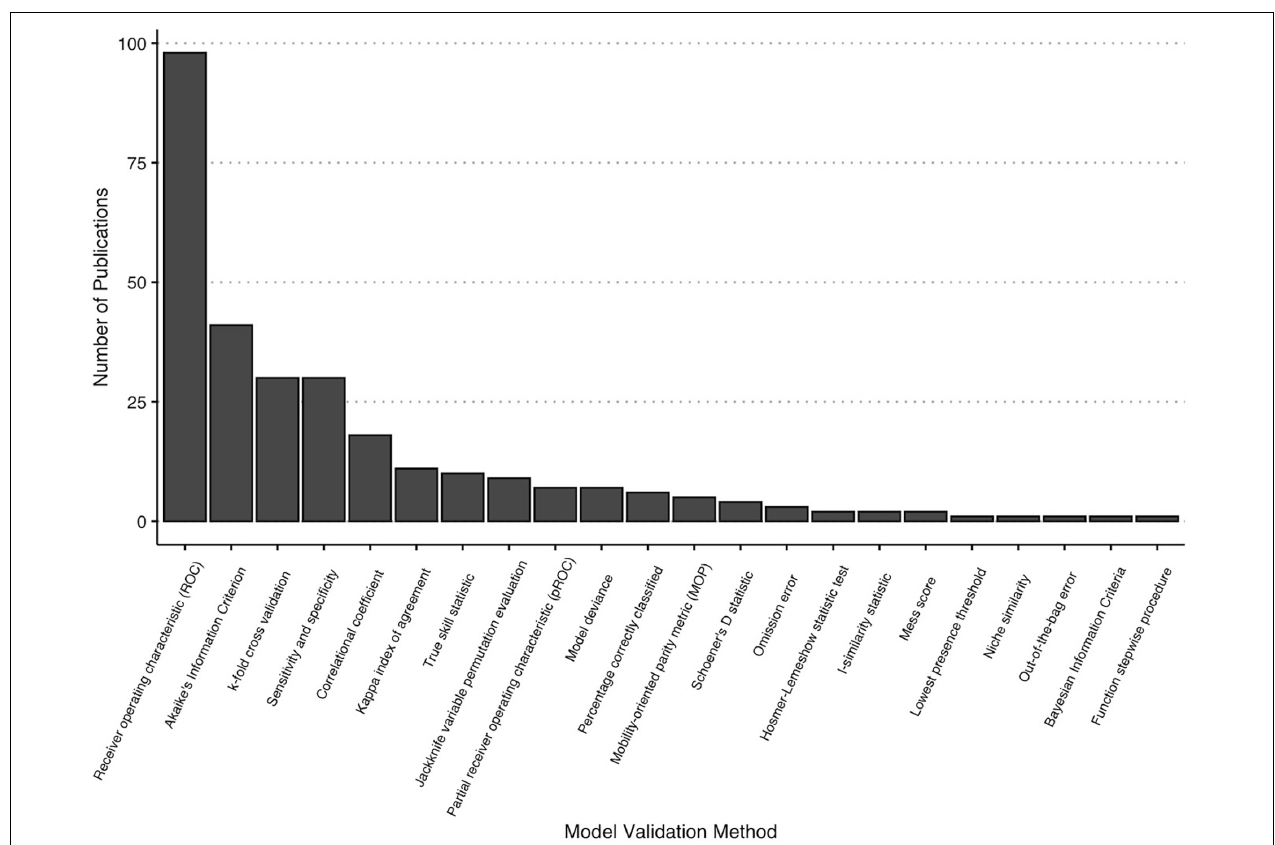
FIGURE 6 | Frequency of model validation methods (n = 22) reported across included